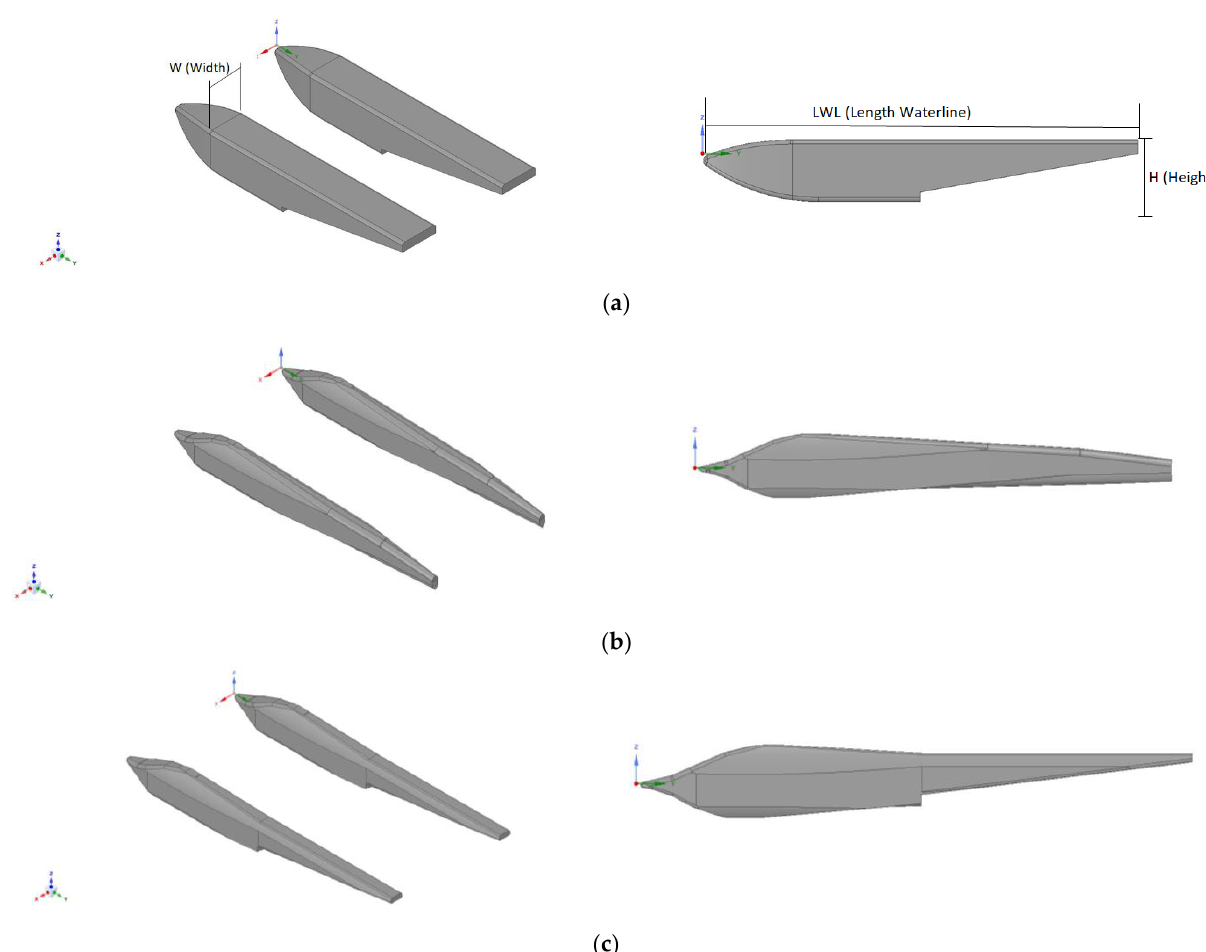
Figure 1. Design model of amphibian float: ( a ) Design control I: WIPLINE ®️ 13000 commercial floating pontoon designs; ( b ) Design control II: The catamaran model with the body of a sailfish; ( c ) Initial design: floating pontoon with sailfish adaptation.